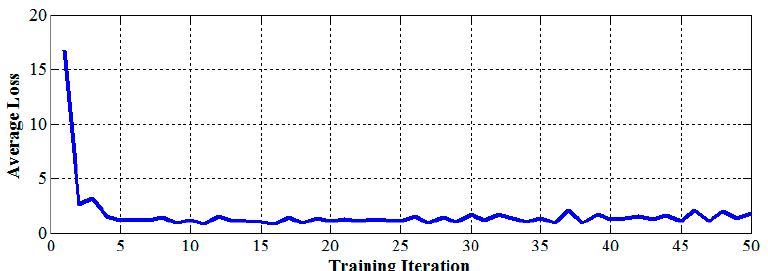
Figure 5. Track of loss.